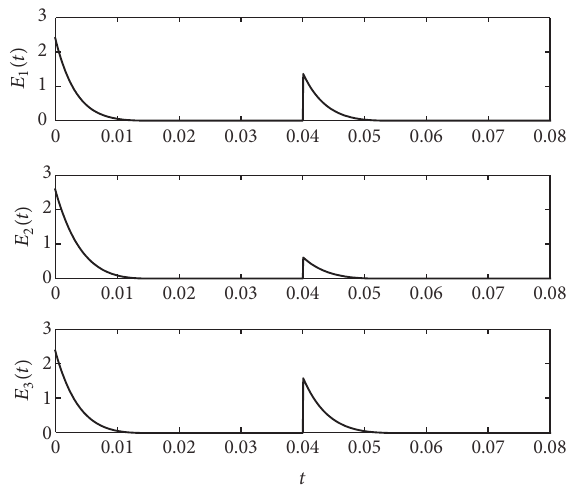
Figure 1: Finite-time bounded synchronization